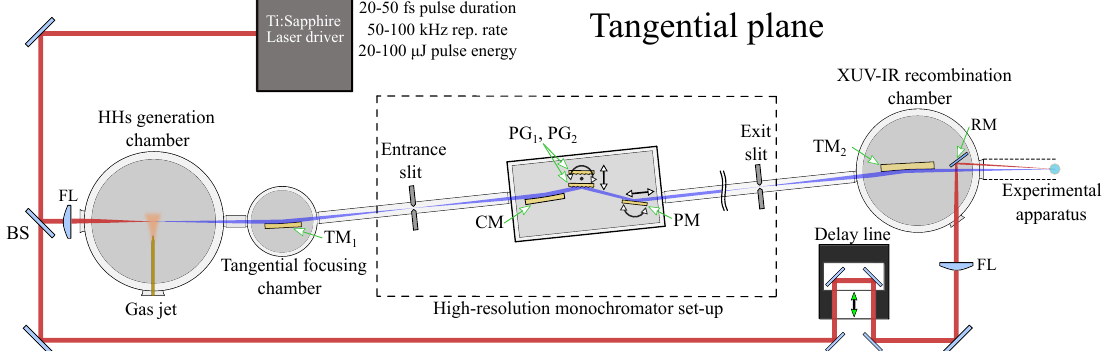
Figure 10. Top-view schematic representing the insertion of the high-resolution monochromator within a high-repetition rate beamline dedicated to pump–probe experiments. The system includes a laser system and optics, the XUV beamline, and the IR delay-line. BS, beam splitter; FL, piano-convex focusing lens; TM 1 , tangential focusing and sagittal collimating toroidal mirror; CM, tangential focusing cylindrical mirror; PG 1 -PG 2 , interchangeable rotating plane gratings; PM, rotating–translating plane mirror; TM 2 , tangential focusing and sagittal focusing toroidal mirror; RM, IR recombination